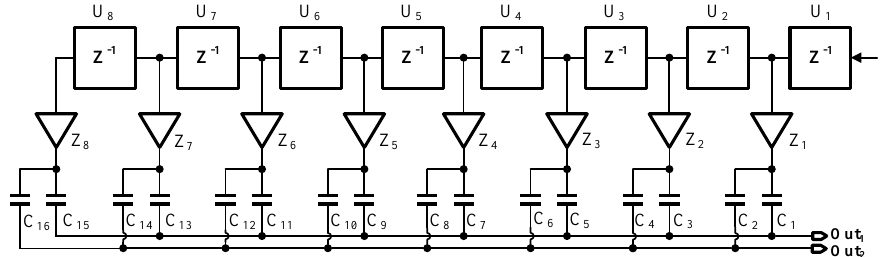
Figure 4. Capacitive multi-phase FIR filter with two